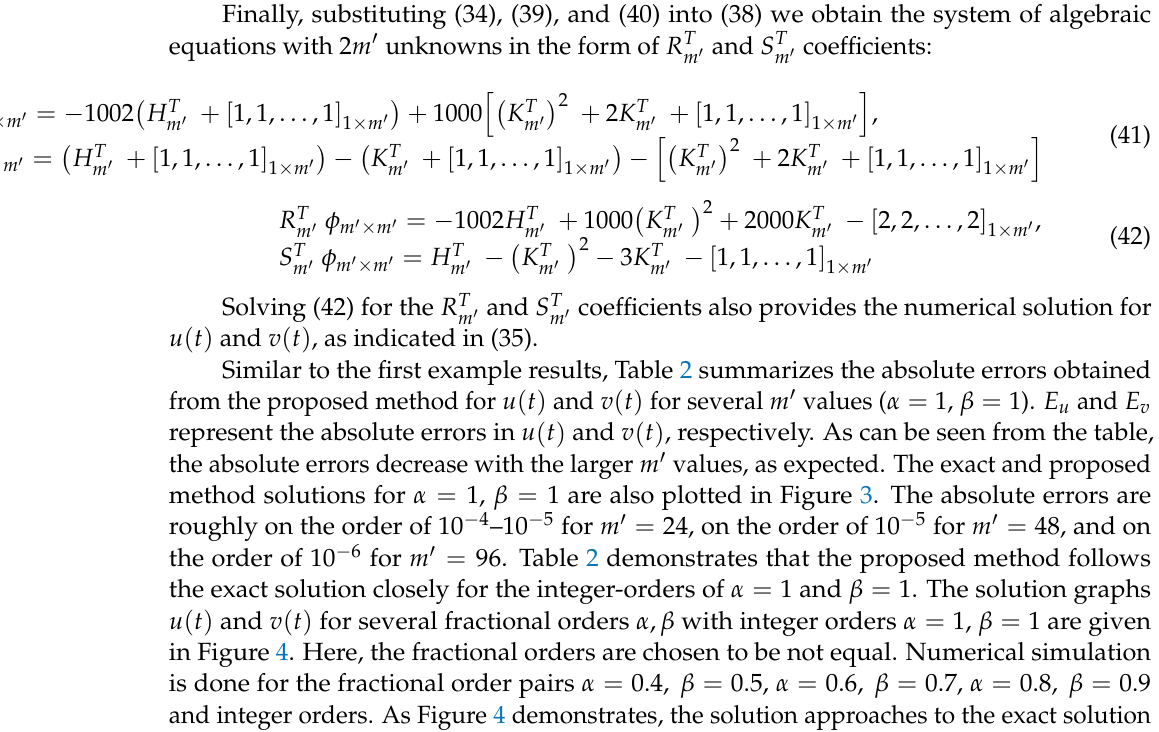
Figure 4. Numerical solutions of